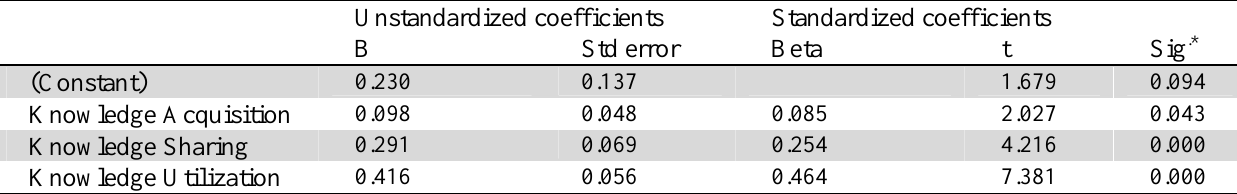
Regression equation- Strategic Leadership and knowledge management Unstandardized coefficients Standardized